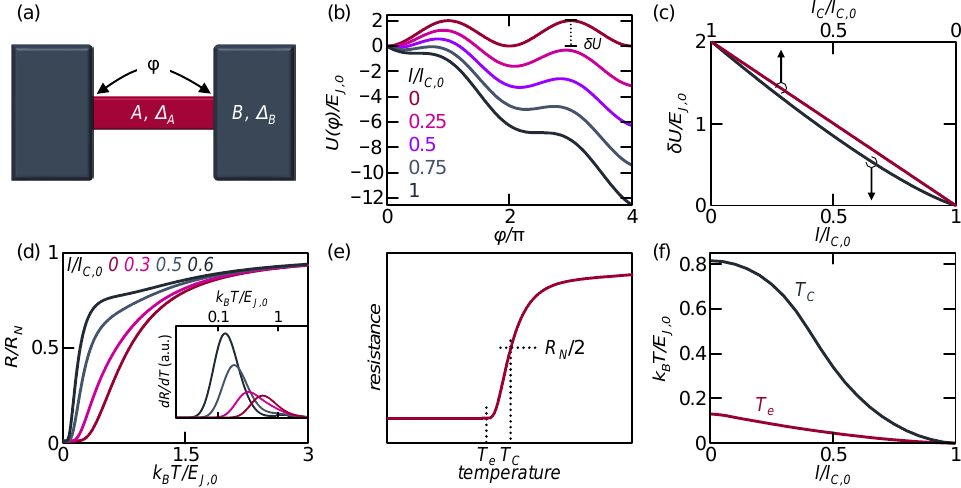
Figure 2. Properties of a 1D fully superconducting Josephson junction (JJ). ( a ) Schematic represen- tation of a 1D fully superconducting JJ, where a superconducting nanowire A is contacted by two superconducting leads B obeying to ∆ A (cid:28) ∆ B (with ∆ A and ∆ B the superconducting energy gap of the nanowire and the leads, respectively). ( b ) Energy of the washboard potential normalized with respect to the zero-temperature Josephson energy as a function of the phase difference across a JJ for different values of bias current. The energy barrier ( δ U ) for the escape of the phase particle from the WP is indicated. ( c ) Energy barrier normalized with respect to the zero-temperature Josephson energy ( δ U / E J ,0 ) calculated as a function of critical current (top) and bias current (bottom). ( d ) Resistance (R) versus temperature (T) characteristics calculated for different values of I . Inset: Temperature derivative of R calculated for different values of I . ( e ) Calculated temperature dependence of the JJ re- sistance, where the escape temperature ( T e ) and the critical temperature ( T C ) are indicated. ( f ) Escape temperature ( T e ) and critical temperature ( T C ) calculated as a function of the bias current ( I